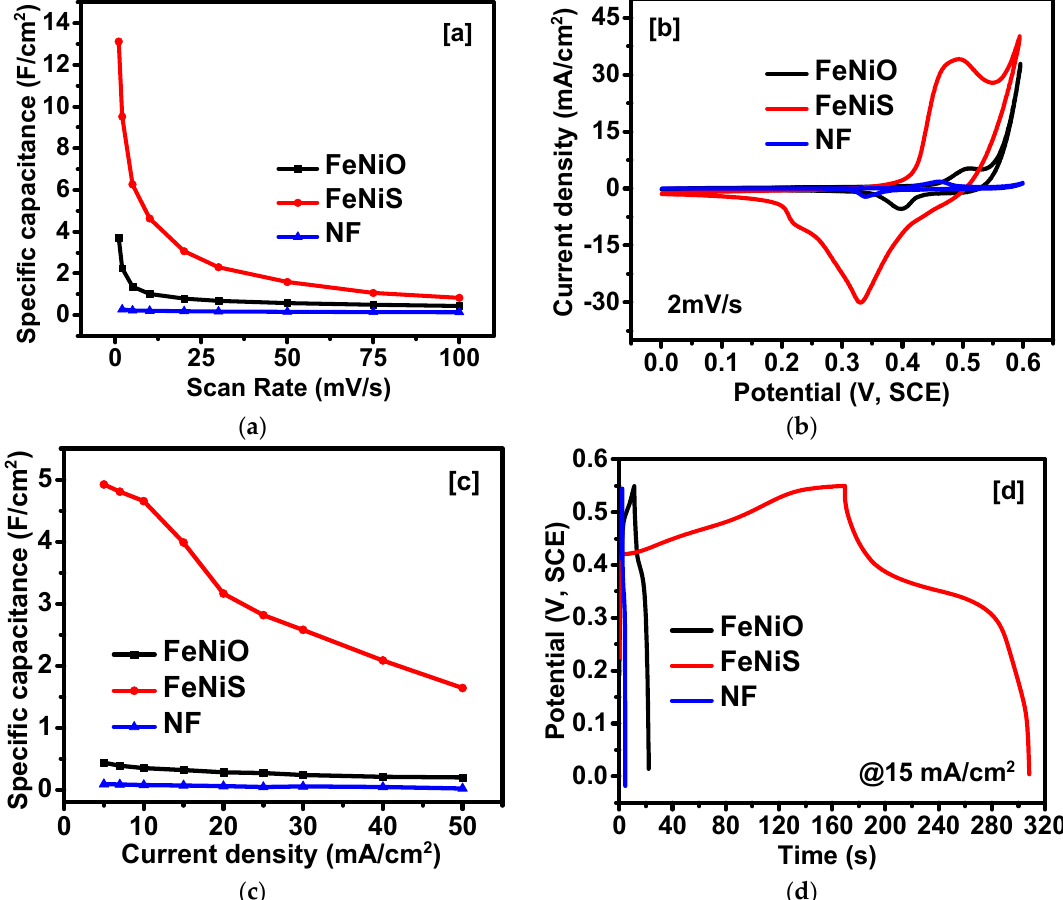
Figure 6. Charge storage behavior for FeNiS, FeNiO and NF: ( a ) specific capacitance vs. scan rate, ( b ) CV curves, ( c ) specific capacitance vs current density and ( d ) charge discharge curves.